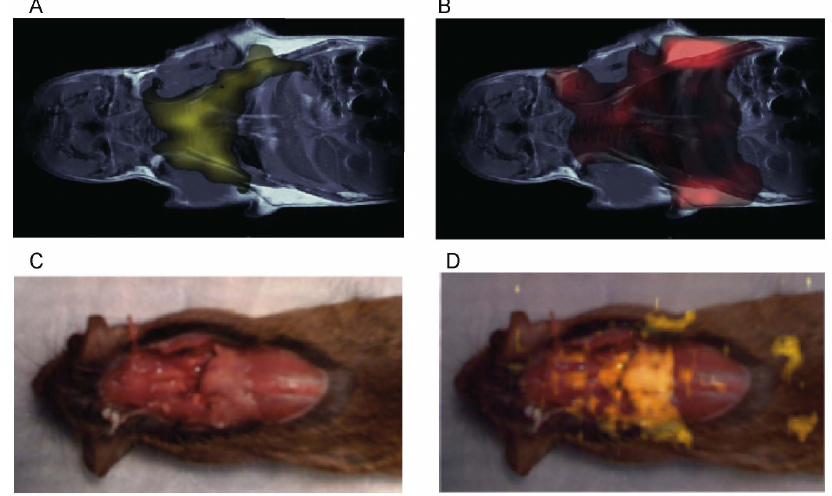
Figure 3. In vivo mapping of BAT using the BATSCI method. ( A ) BATSCI map in a C57 mouse highlighting the BAT depot. ( B ) Fat-fat iZQC map on the same C57 mouse highlighting both WAT and BAT depots. ( C ) Photograph of a Caveolin-1 null mouse showing the interscapular brown fat depot (pale pink). ( D ) BATSCI map overlapped on the anatomical photograph, highlighting the interscapular BAT depot and the peri-renal BAT depots (not visible in the photograph).